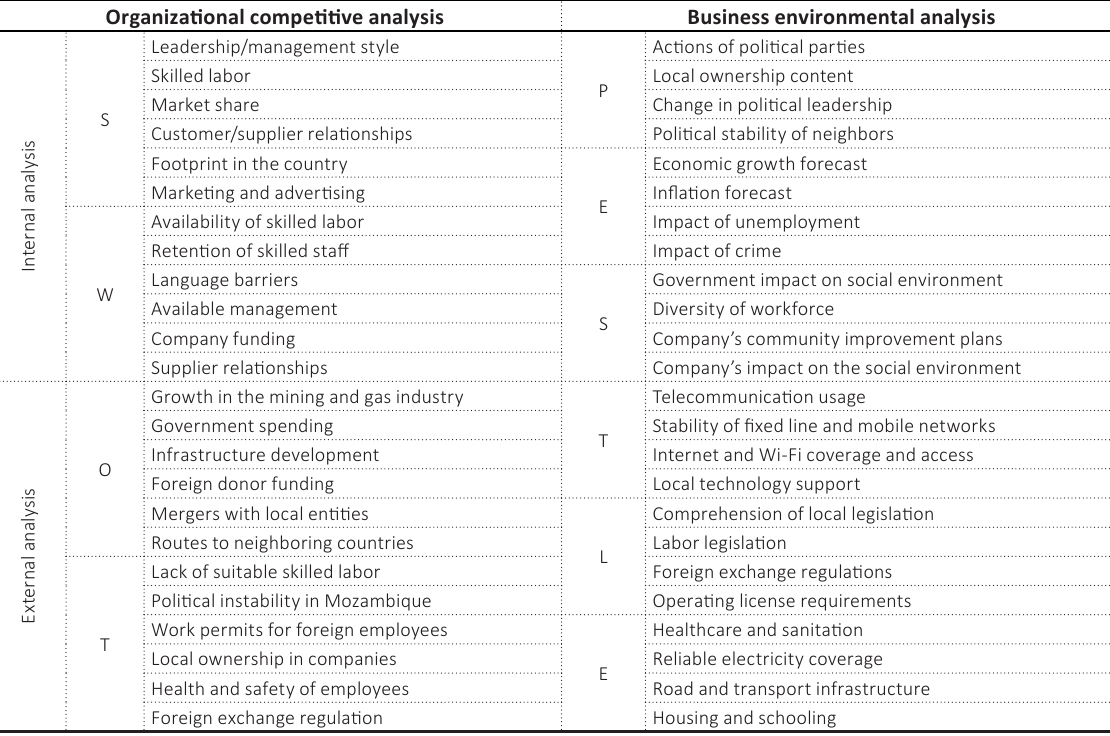
Table 1. Decision support framework for strategic investment in Mozambique Organizational competitive